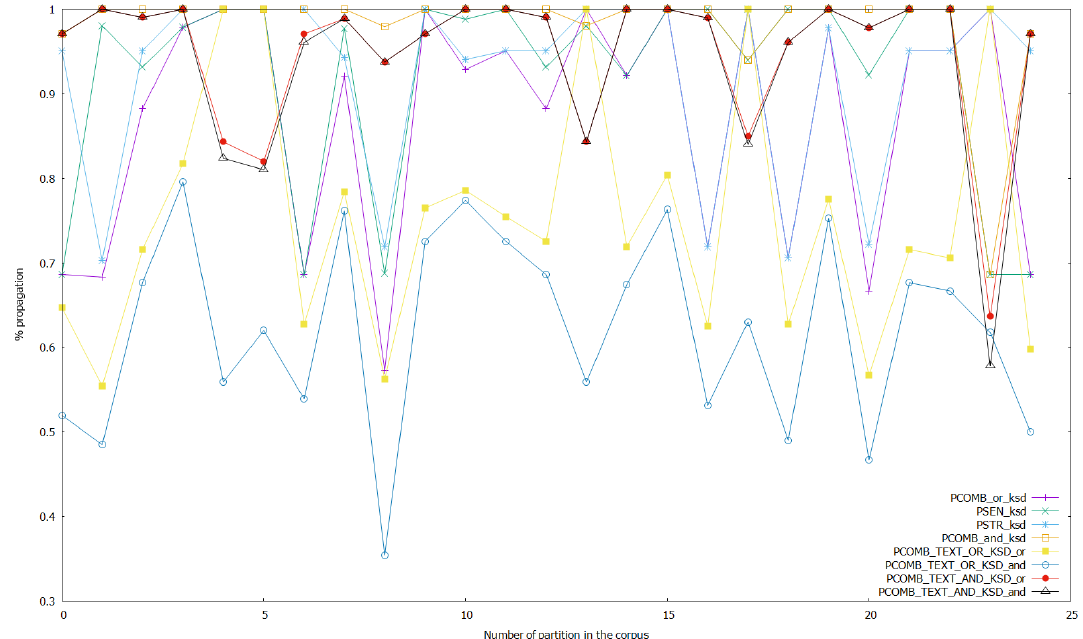
Figure 9. Results of the experiments with the sentiment, stress, and combined analyses on keystroke data, and with the combined analyses on text and keystroke data with threshold set to 0.7 in the ANNs that work with text